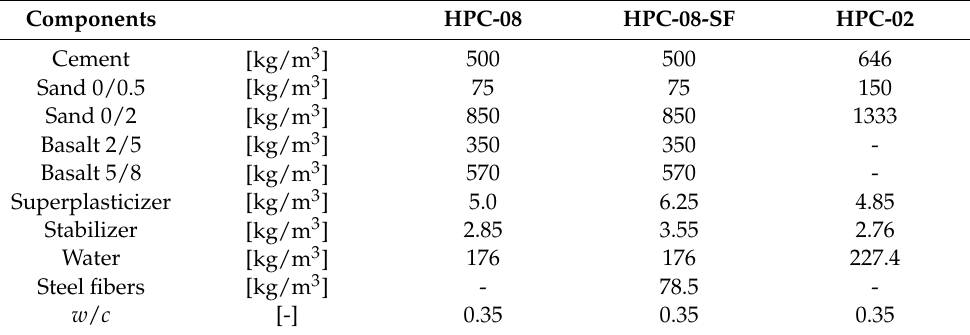
Table 1. Compositions of high-performance mortar (HPC-02) and concrete with (HPC-08-SF) and without fibers (HPC-08).